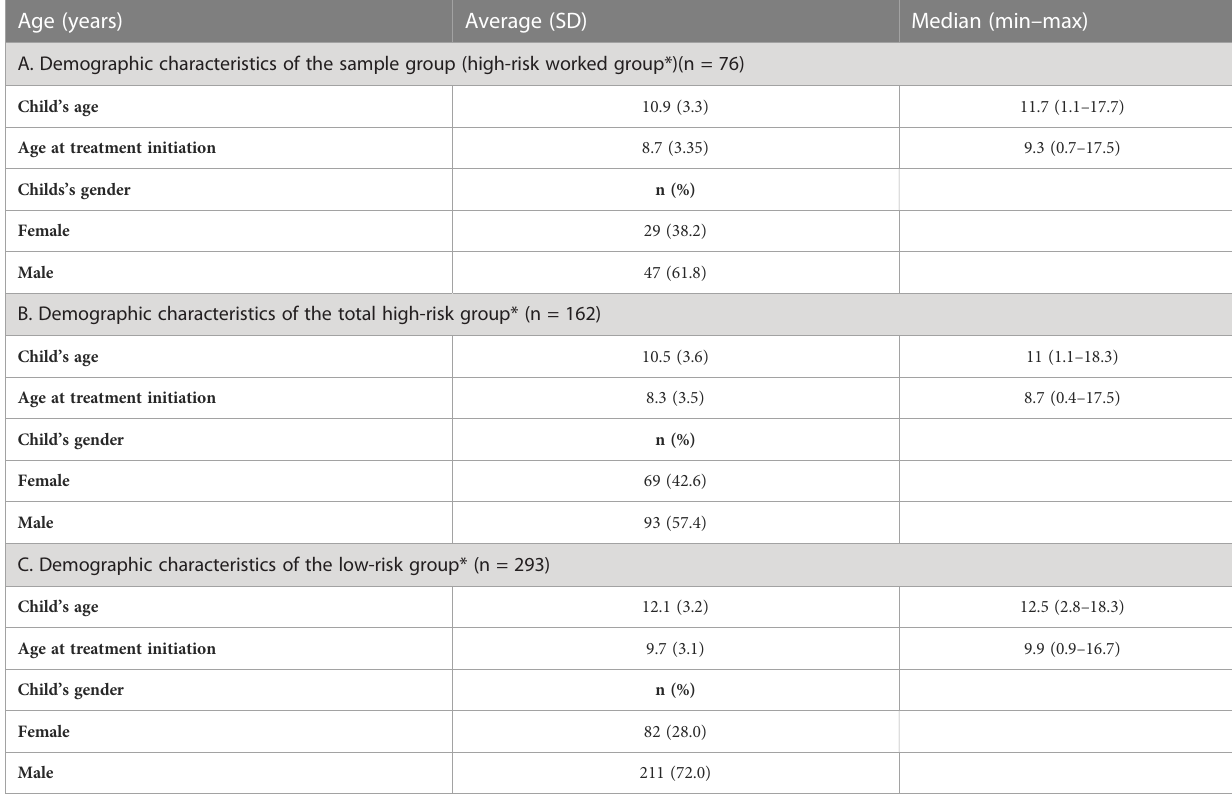
TABLE 1 Demographic characteristics of the sample group (high risk worked), total high-risk group, and low-risk